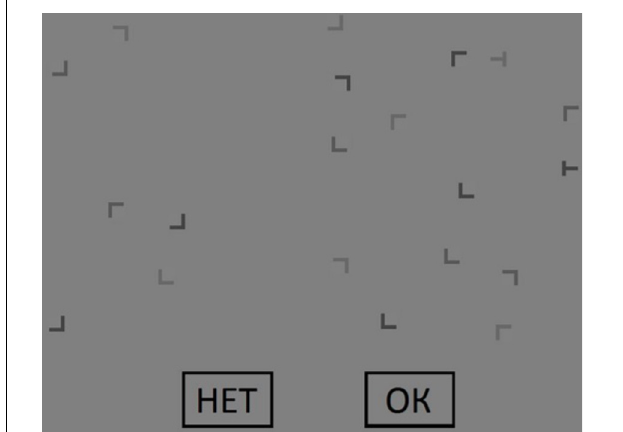
FIGURE 1 | An example of the experimental trial. The target is the form of the letter “T.” There are two targets: one high-salient and one low-salient target. The button “HET” means